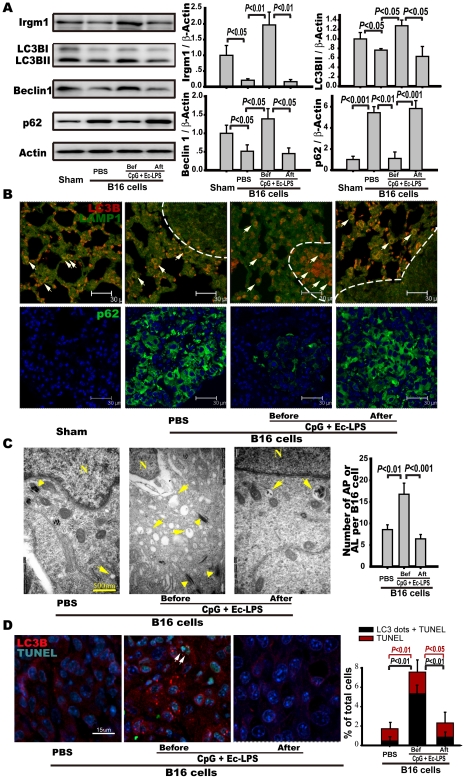
Prophylactic, but not therapeutic, application of TLR4/TLR9 agonist complex activates autophagy in melanoma cells.Mice were treated as indicated in the legend of Figure 1 and sacrificed 14 days after B16 melanoma cell inoculation. The lungs were obtained, and tissue extracts or lung sections were prepared for indicated analysis. (A) The expression of IRGM1, LC3B-II/LC3B-I, beclin-1, and p62 in the lung tissues were detected with Western blot analysis. The representative immune blots are shown in left panel, and statistical results are shown in the right panel. Data are the mean ± S.E. (n = 5). (B) Upper: representative immunofluorescence microphotograph of LC3B and LAMP-1. Lung sections were stained for LC3 (red) and LAMP-1 (green). Arrows point to LC3- and Lamp1- positive cells. Scale bar: 30 µm. Bottom: representative immunofluorescence microphotograph of p62 accumulation. Lung sections were stained for p62 (green) and DAPI (blue). Green areas indicate accumulation of p62 in melanoma cells. Scale bar: 30 µm. (C) Analysis of autophagy in lung sections by transmission electron micrograph (TEM). Autophagosomes and autolysosomes were counted in 10 melanoma cells in every lung section. Data are the mean ± S.E (n = 4 mice/group). Typical autophagosomes and autolysosomes (asterisk) and melanin granules (arrowheads) are indicated. N indicates nuclei of the cell. Scale bar: 500 nm. (D) Co-localization of LC3B immunostaining (red) and TUNEL (green) in the tumor nodes was detected in lung tissue sections. Left three panels are representative images. Arrows point to cells with LC3 dots and TUNEL-positive nuclei. Scale bar: 15 µm. Right panel is bar graph showing the percentage of cells with TUNEL-positive nuclei or with TUNEL positive nuclei and LC3 dots relative to the total number of cells in each section. Twelve images from each lung specimen were counted. Data are presented as the mean ± S.E (n = 6 mice per group).